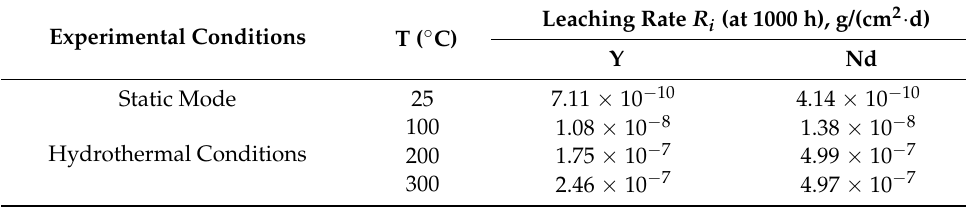
Table 1. Minimum achieved leaching rate of